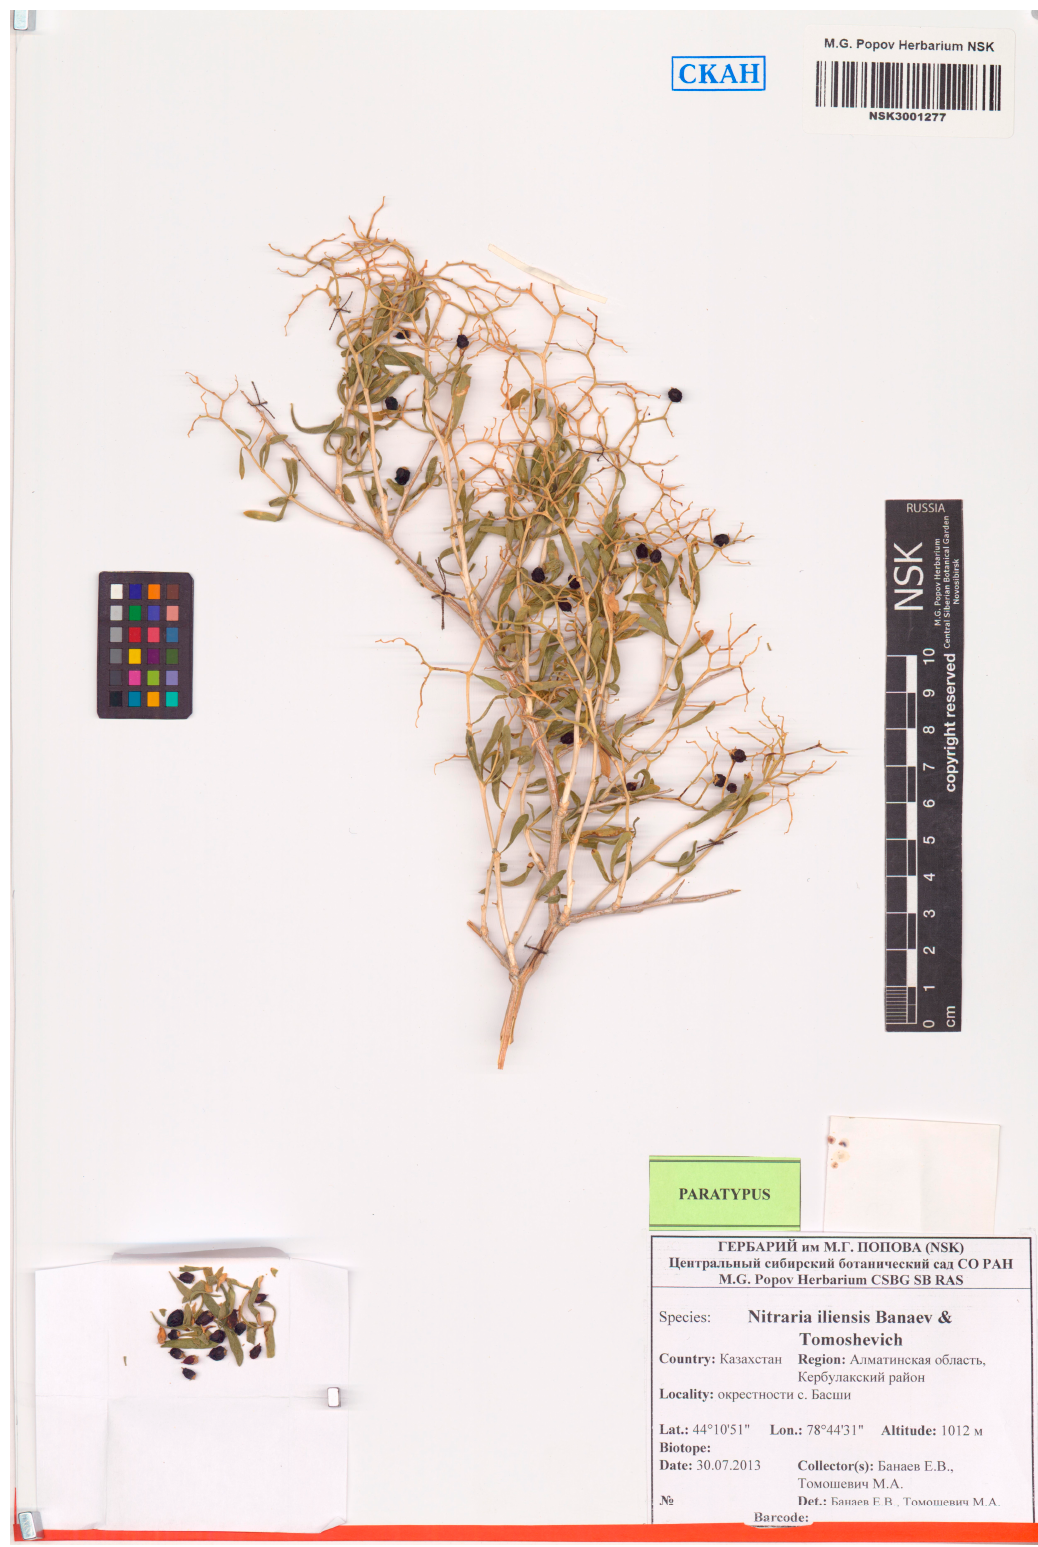
Figure 7. Paratype of N. iliensis Banaev & Tomoshevich, sp. nov. (NSK 3001277).